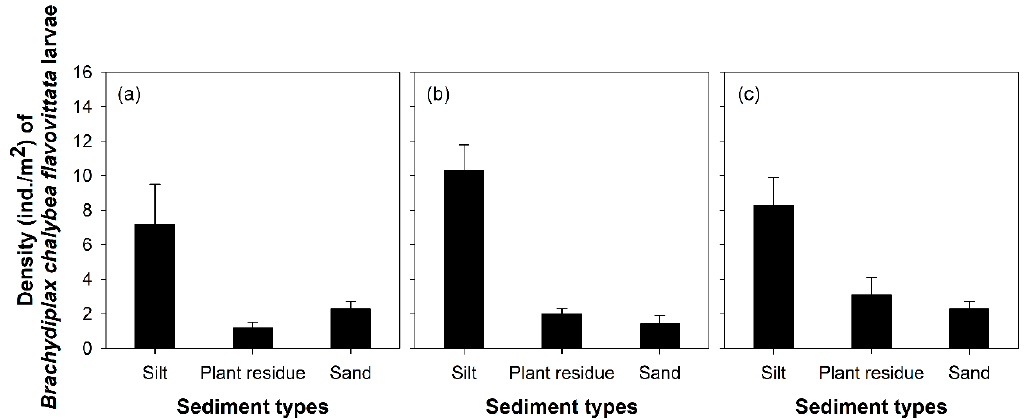
Figure 5. Density of Brachydiplax chalybea flavovittata larvae in three sediment types. ( a ) site 1, ( b ) site 5, and ( c ) site 14.